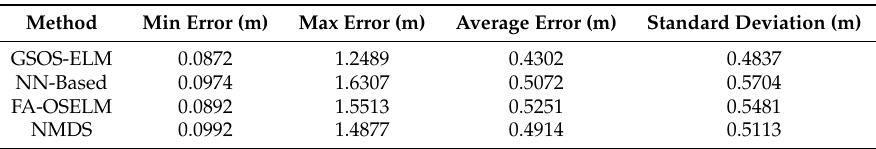
Table 7. Comparison Results under Realistic Environment.